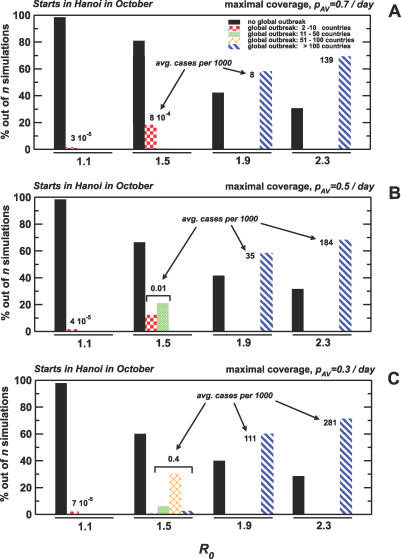
Intervention Scenario with Maximal AV Coverage: Probability of Global Outbreaks for a Pandemic Seeded in Hanoi in OctoberProbability of observing a global outbreak after one year from the beginning of the epidemic, for the values R0 = 1.1, 1.5, 1.9, and 2.3. A maximal coverage with unlimited AV supplies in all hit countries is assumed. Symptomatic cases receive AV drugs with rate pAV = 0.7/d (A), 0.5/d (B), and 0.3/d (C).